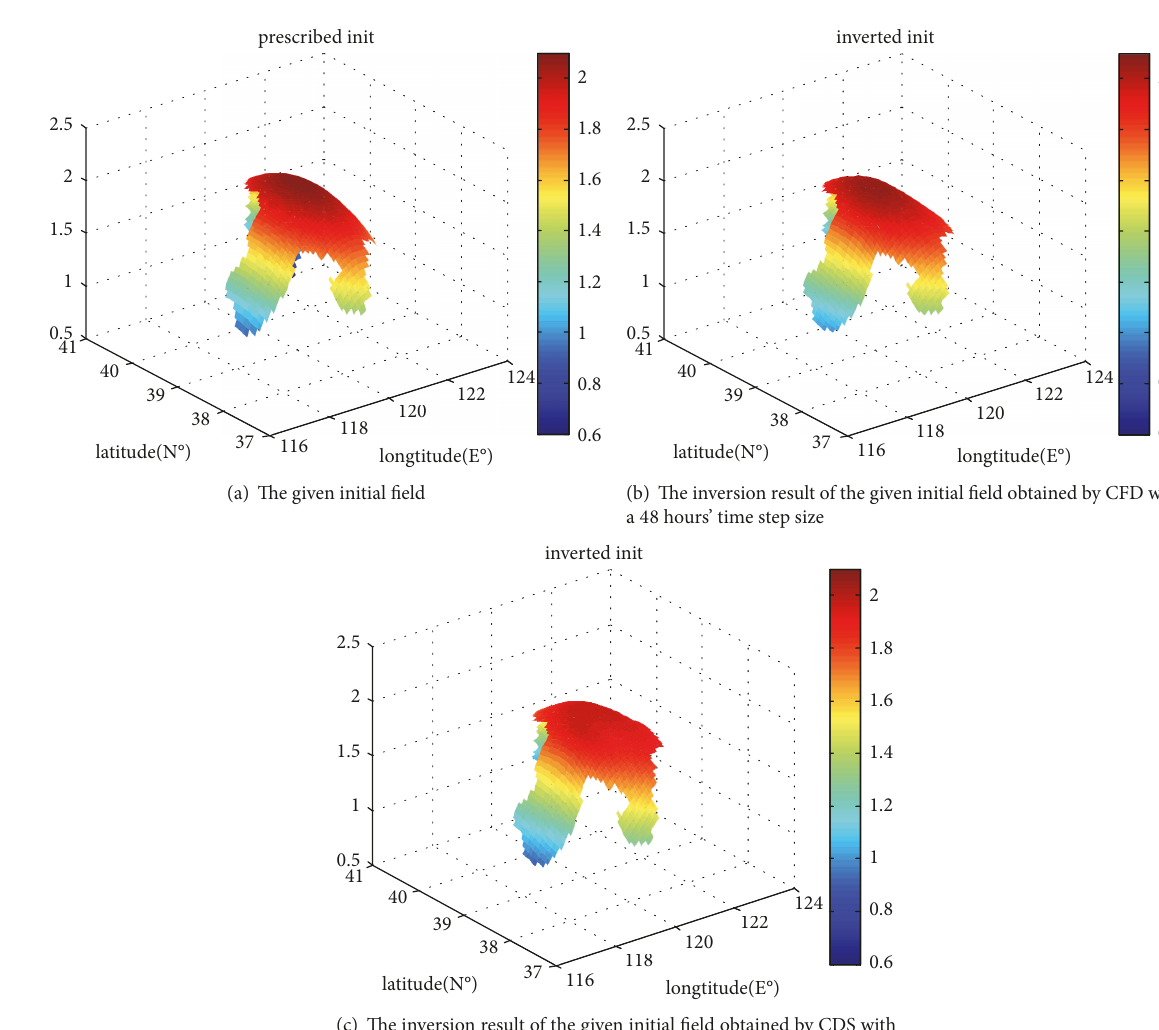
Figure 5: Figures of the initial distribution inverted by the adjoint method of data assimilation with CFD and CDS.